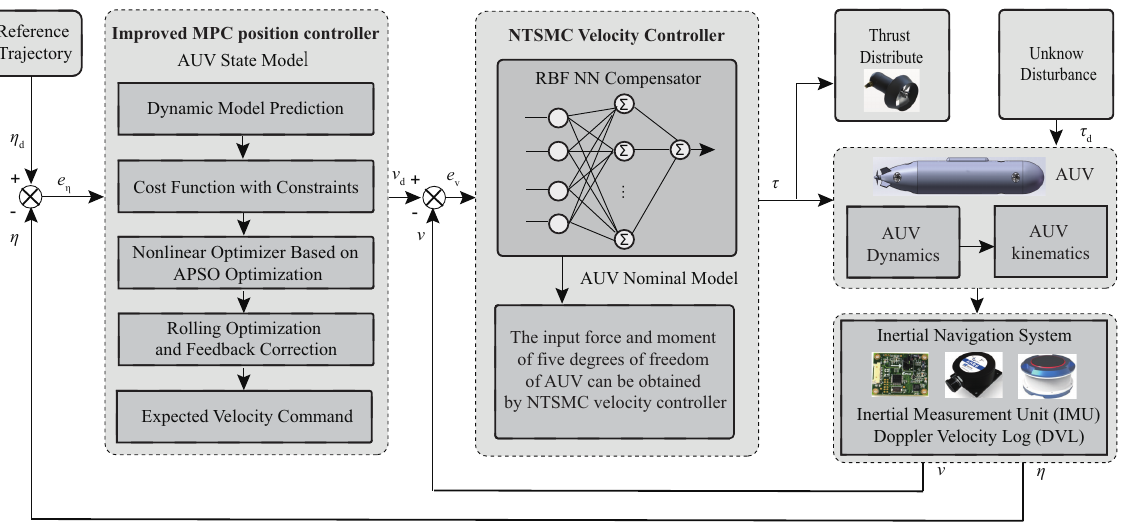
Figure 7. Diagram of the fully actuated AUV control